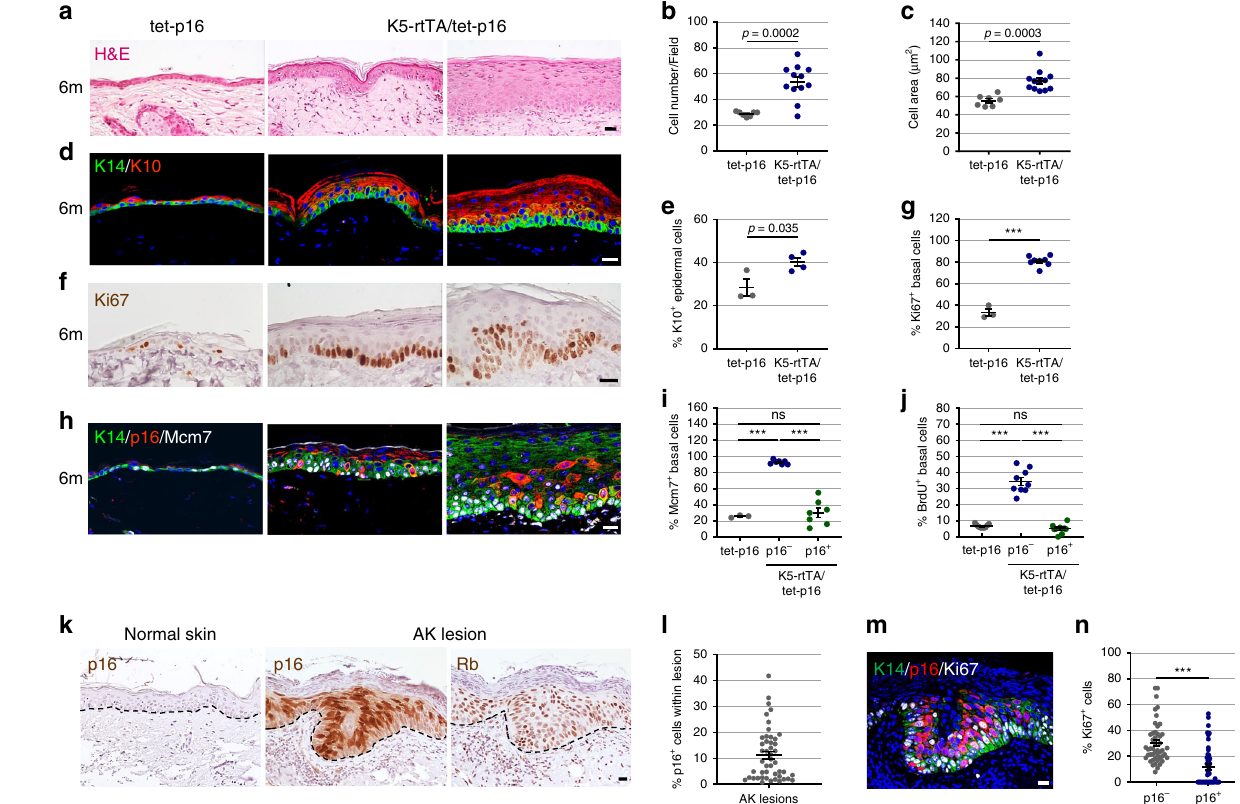
Fig. 2 Chronic p16 expression causes epidermal hyperplasia and dysplasia. a H&E-stained skin sections of K5-rtTA/tet-p16 and control tet-p16 mice treated with dox for 6 months (6m). Typical (middle) and pronounced (right) phenotype regions are shown for p16-induced mice. b IFE keratinocyte cell number per fi eld (40×) in indicated mice (dots). n = 7, 12 in respective groups. c Average area of IFE cells from the same mice, visually measured from E- cadherin-stained sections. n = 7, 12. d Sections from the same mice stained for K10 (red) labeling suprabasal cells and K14 (green) labeling basal cells. e Percentage of K10 + epidermal cells isolated from dissociated mouse ear epidermis of indicated mice (dots) after 6 months of dox treatment, scored by FACS. n = 3, 4. f Skin sections from the indicated mice stained for Ki67 (brown). Right image shows a region with dysplasia. g Percentage of Ki67 + basal IFE cells in indicated mice (dots) after 6 months of dox treatment. n = 3, 8. h Skin sections from same mice co-stained for human p16 (red), the proliferation marker Mcm7 (white) and K14 (green). i Percentage of Mcm7 + basal IFE cells in control mice (tet-p16), and among p16 − and p16 + cells in the epidermis of K5-rtTA/tet-p16 mice treated with dox for 6 months. n = 3, 7, 7. j Percentage of BrdU + basal epidermal cells in same mice, scored from skin sections co-stained for BrdU and p16. n = 9 per group. k Serial sections of a human actinic keratosis lesion stained for p16 (middle) and Rb (right) (both brown). Staining for p16 in normal human skin is shown in left panel. Dotted lines label the basement membrane. l Percentage of p16 + cells within individual human actinic keratosis (AK) lesions (dots), among lesions showing p16 expression. n = 47. m AK lesion co-stained for p16 (red), Ki67 (white) and K14 (green). n Percentage of Ki67 + cells among p16 − and p16 + cells in human AK lesions (dots). n = 47. All graphs indicate mean across mice ± S.E.M, except panels l , n which indicate mean across lesions. All scores were conducted visually on images, except e . Blue labels DNA in all images. *** P < 0.0001, t test. ns non-signi fi cant. Scale bars — 20 μ